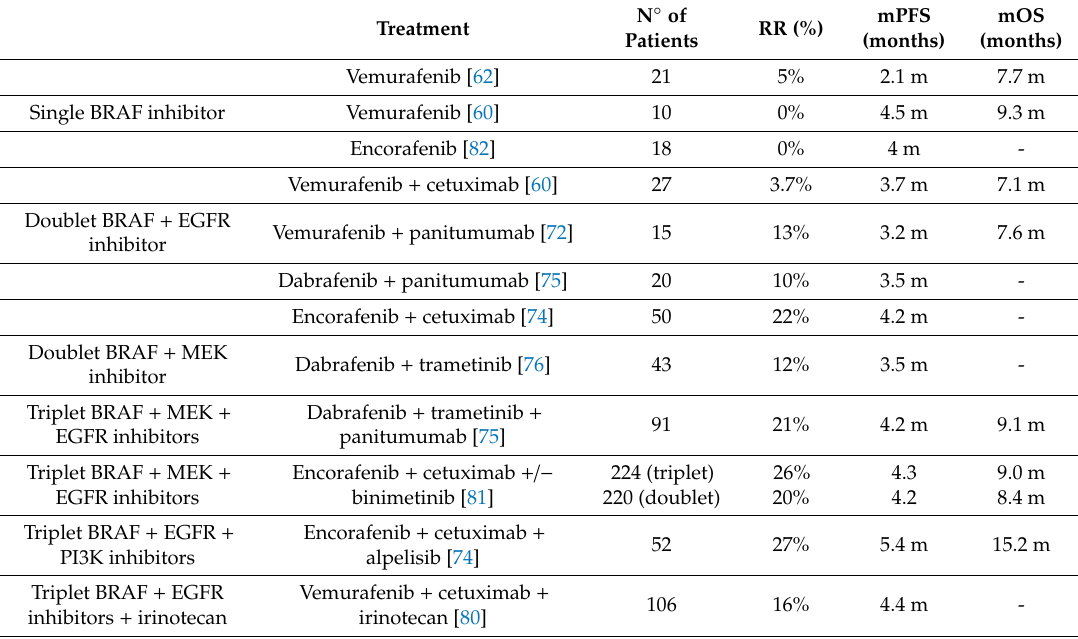
Table 1. Main clinical trials with BRAF-inhibitors in BRAF-mutated